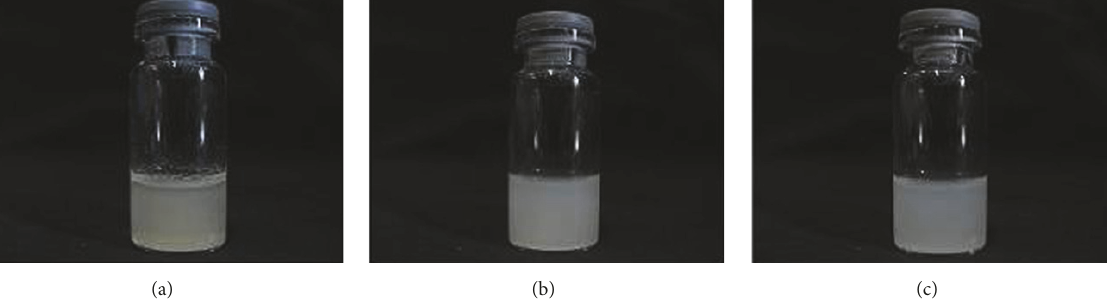
Figure 8: Dispersion appearances in water of (a) HCPT primary particles, (b) HCPT nanocolloidal particles, and (c) freeze-dried HCPT nanocolloidal particles.